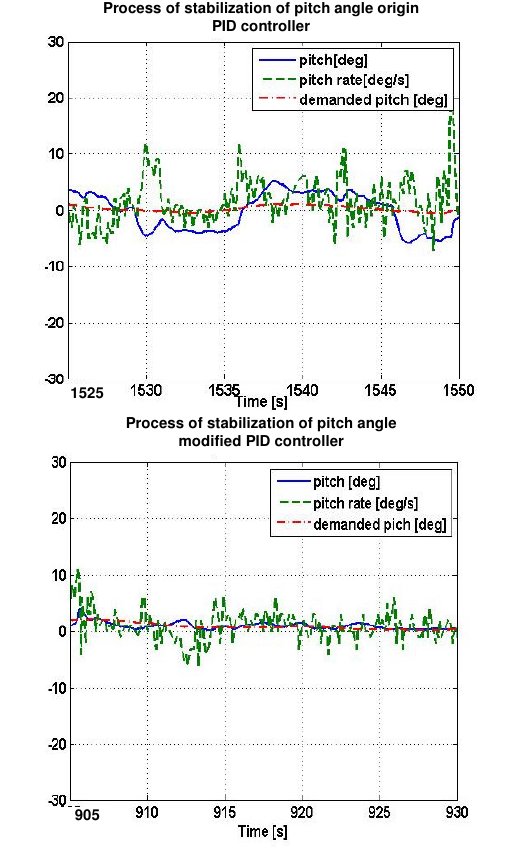
Fig 7. Process of pitch angle stabilization by pure PID controller (upper) and extended PID controller